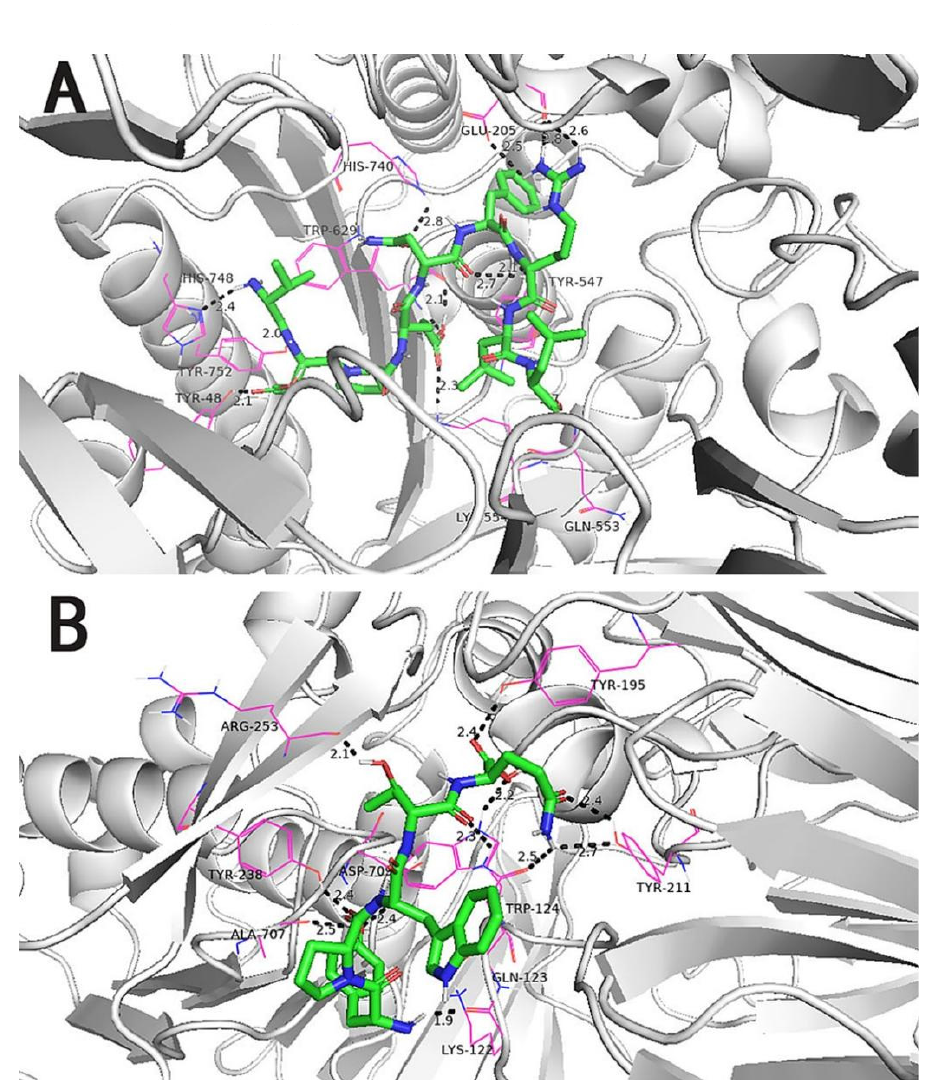
Figure 3. ( A ) Molecular docking diagram of VDPENFRLL and DPP-IV. ( B ) Molecular docking diagram of YPWTQ and DPP-IV. Table 4. Peptide Ranker score and binding energy data for docking. Table 6. Blood glucose changes of mice in the different treatment